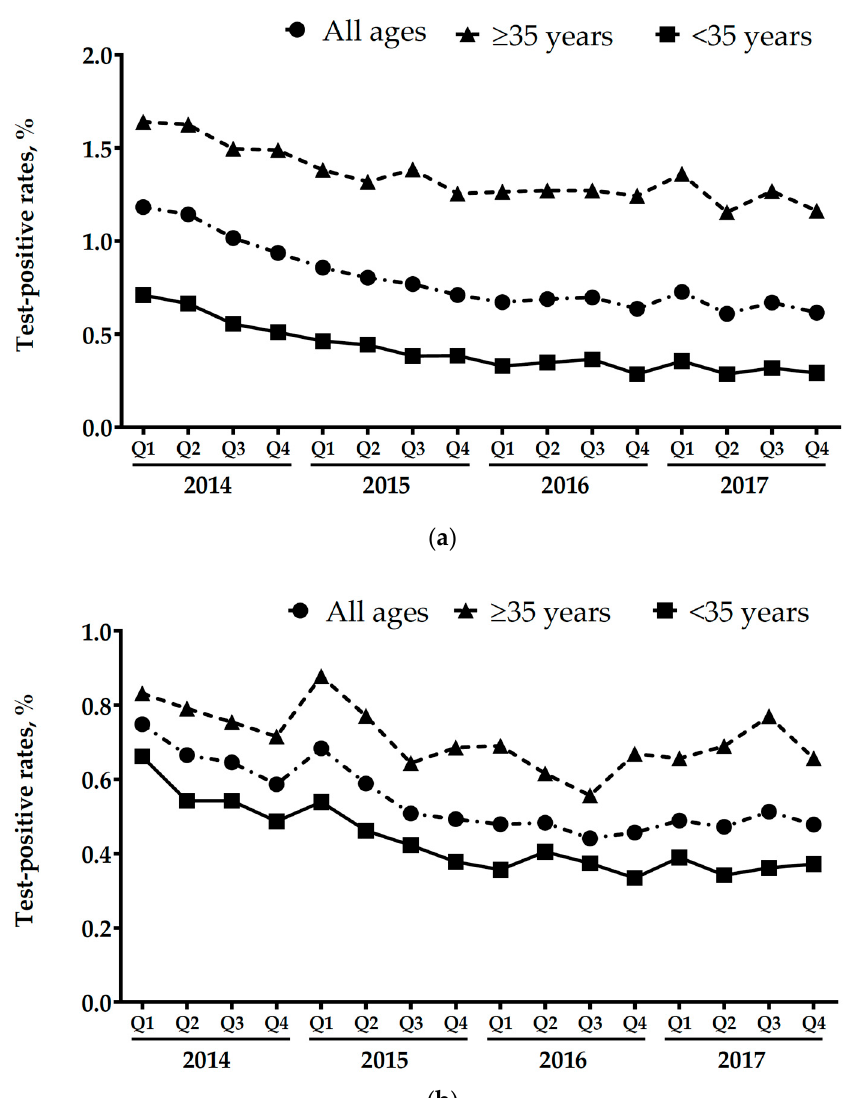
Figure 2. Test-positive rates by quarter, 2014–2017. ( a ) Test positive for trisomy 21; ( b ) Test positive for either trisomy 18, trisomy 13, or monosomy X.